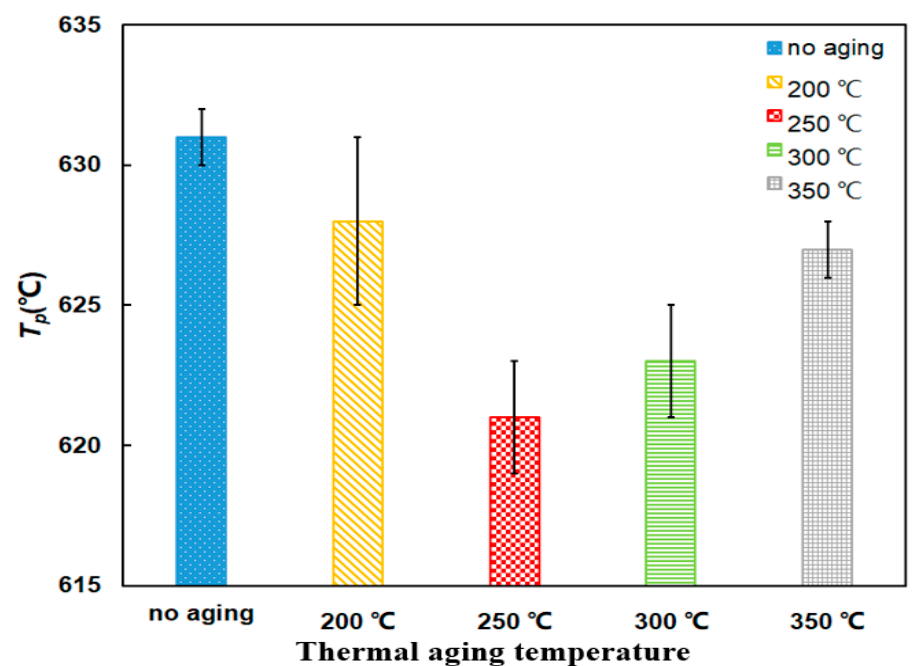
Figure 11. Comparison of T p of PU/Pt mixtures at different thermal aging temperatures.